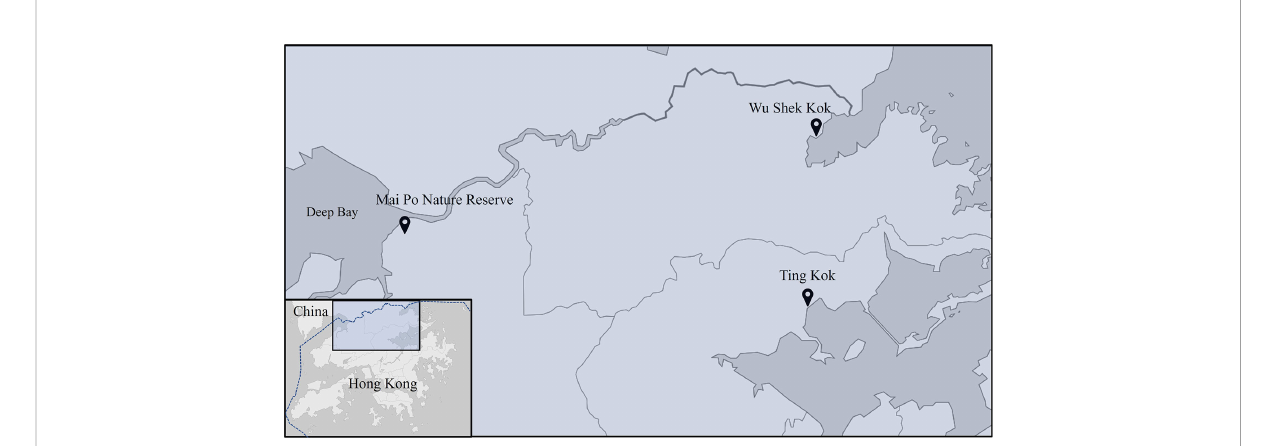
FIGURE 1 Map of fi eld sites. Most crab species were collected in Ting Kok (Table 1), while Parasesarma af fi ne and Episesarma versicolor were collected from Mai Po Nature Reserve and Wu Shek Kok, respectively, because of their high abundance at corresponding